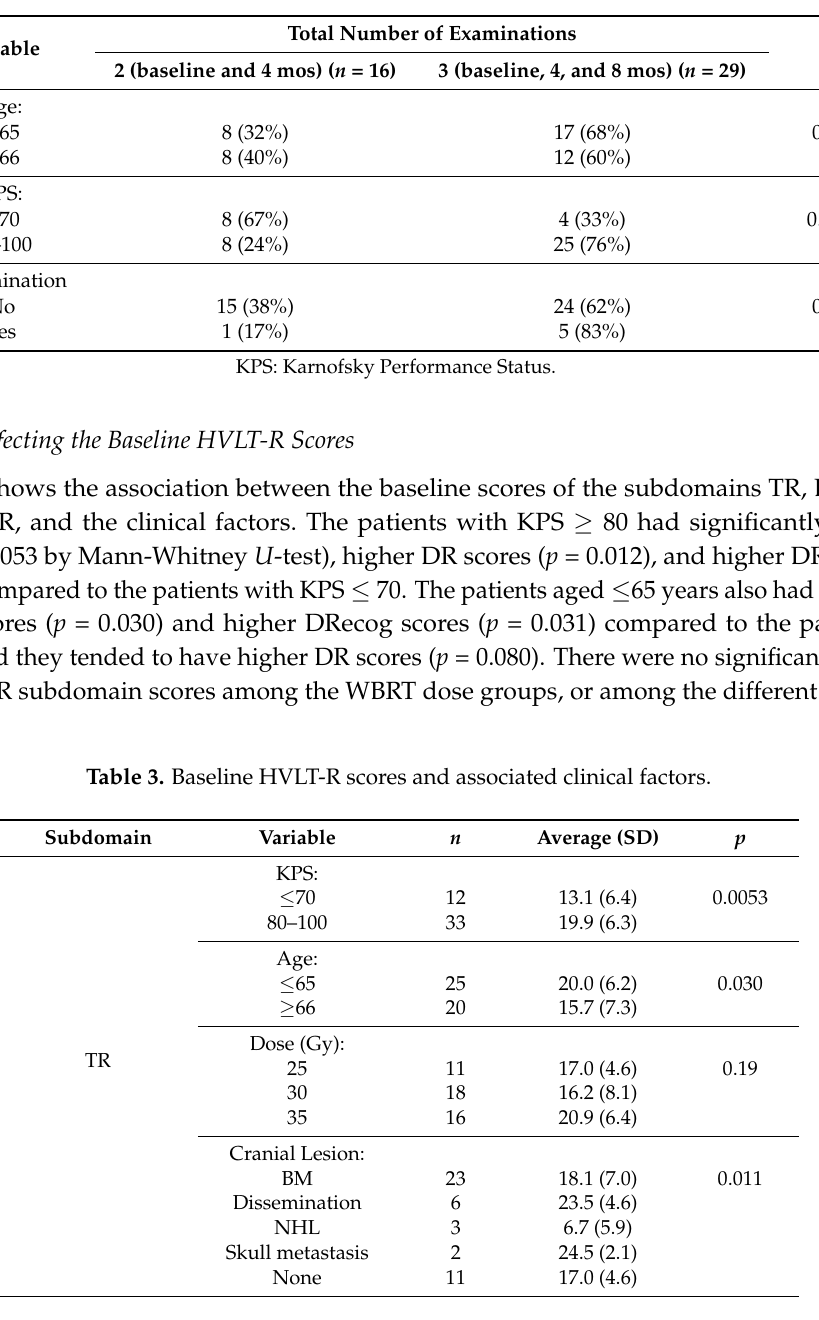
Table 2. Age, KPS, leptomeningeal dissemination and total number of examinations.